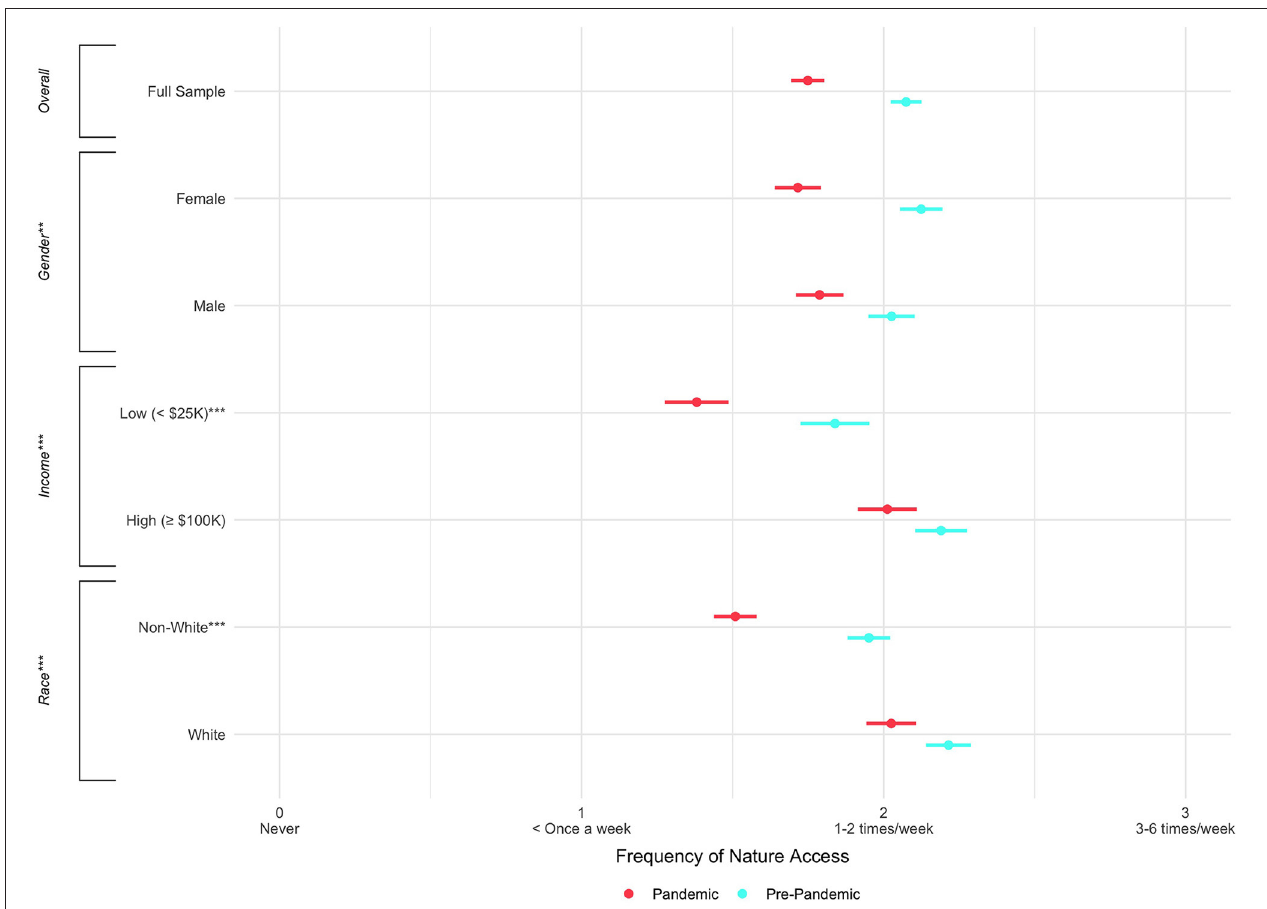
FIGURE 1 | Time spent in nature before and during the pandemic. Dots show mean ± SE. Significance at demographic group level (left brackets) is from mixed ANOVAs for differences between groups over time. Significance at group level is from t -tests for differences between groups at each time period (results are the same for pre-pandemic and mid-pandemic comparisons). ** p < 0.01, *** p < 0.001.